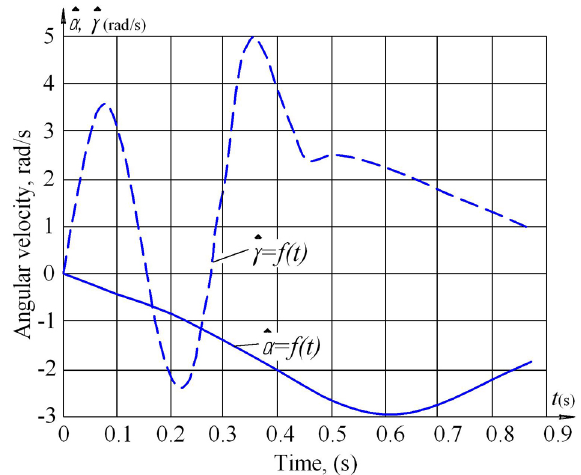
Figure 8. Changing the angular velocities of the supporting leg α (cid:5) and thigh of the free leg γ (cid:5)